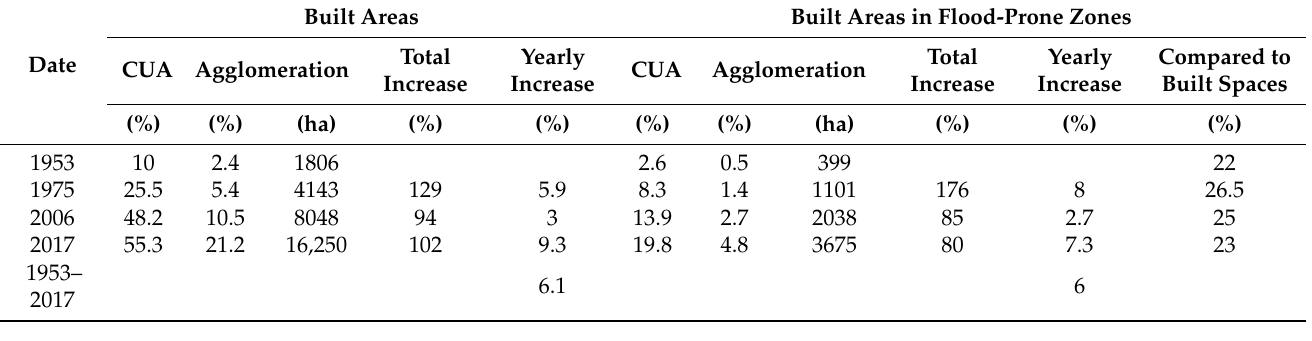
Table 2. Extent and increase of urbanized cells and built areas in flood-prone zones.